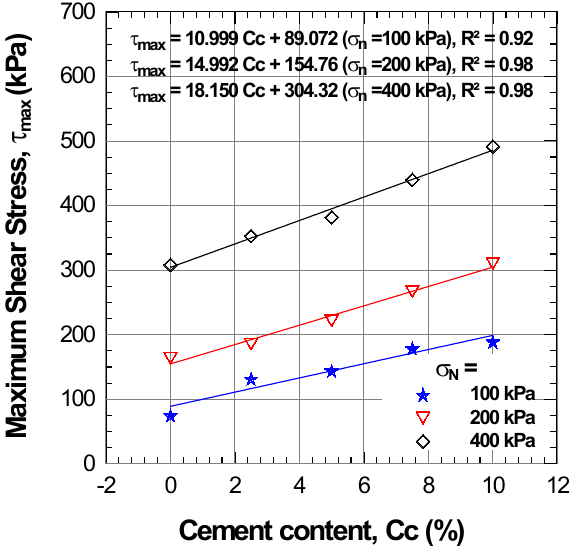
Figure 7: Evolution of the maximum shear strength of cemented reinforced sand as function of cement content (case of a water content ω =